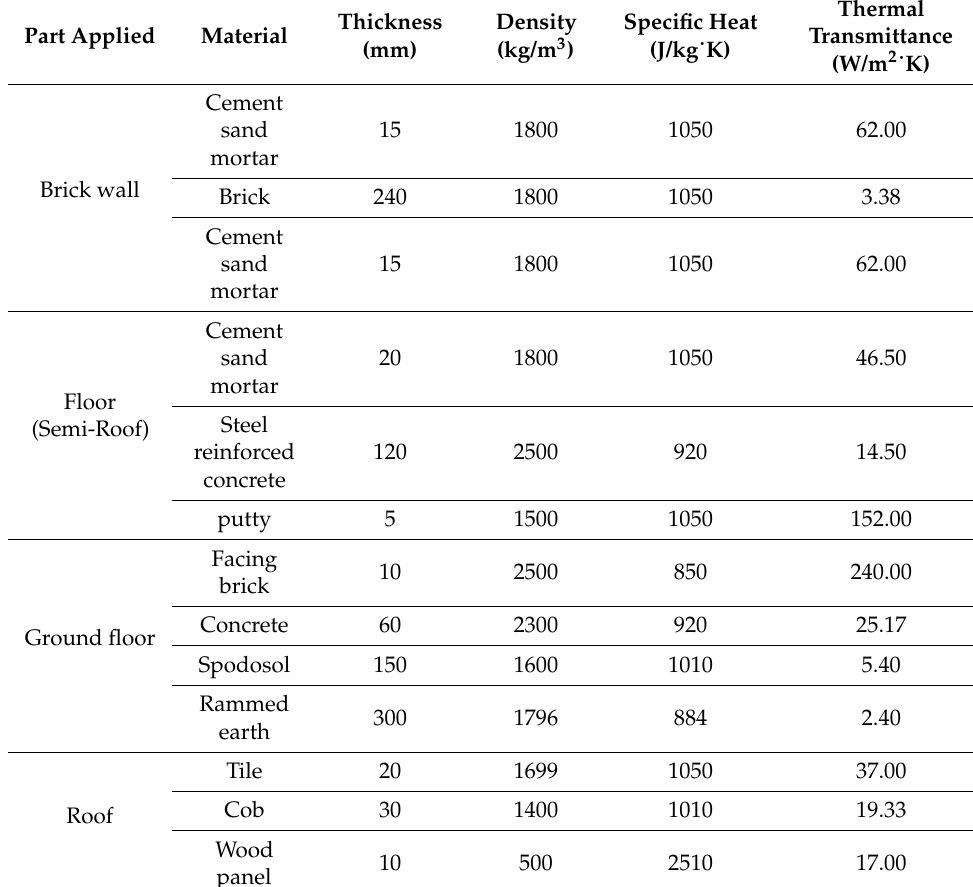
Table 3. Materials and their thermal coefficients of a typical rural house in Xi’an, China.